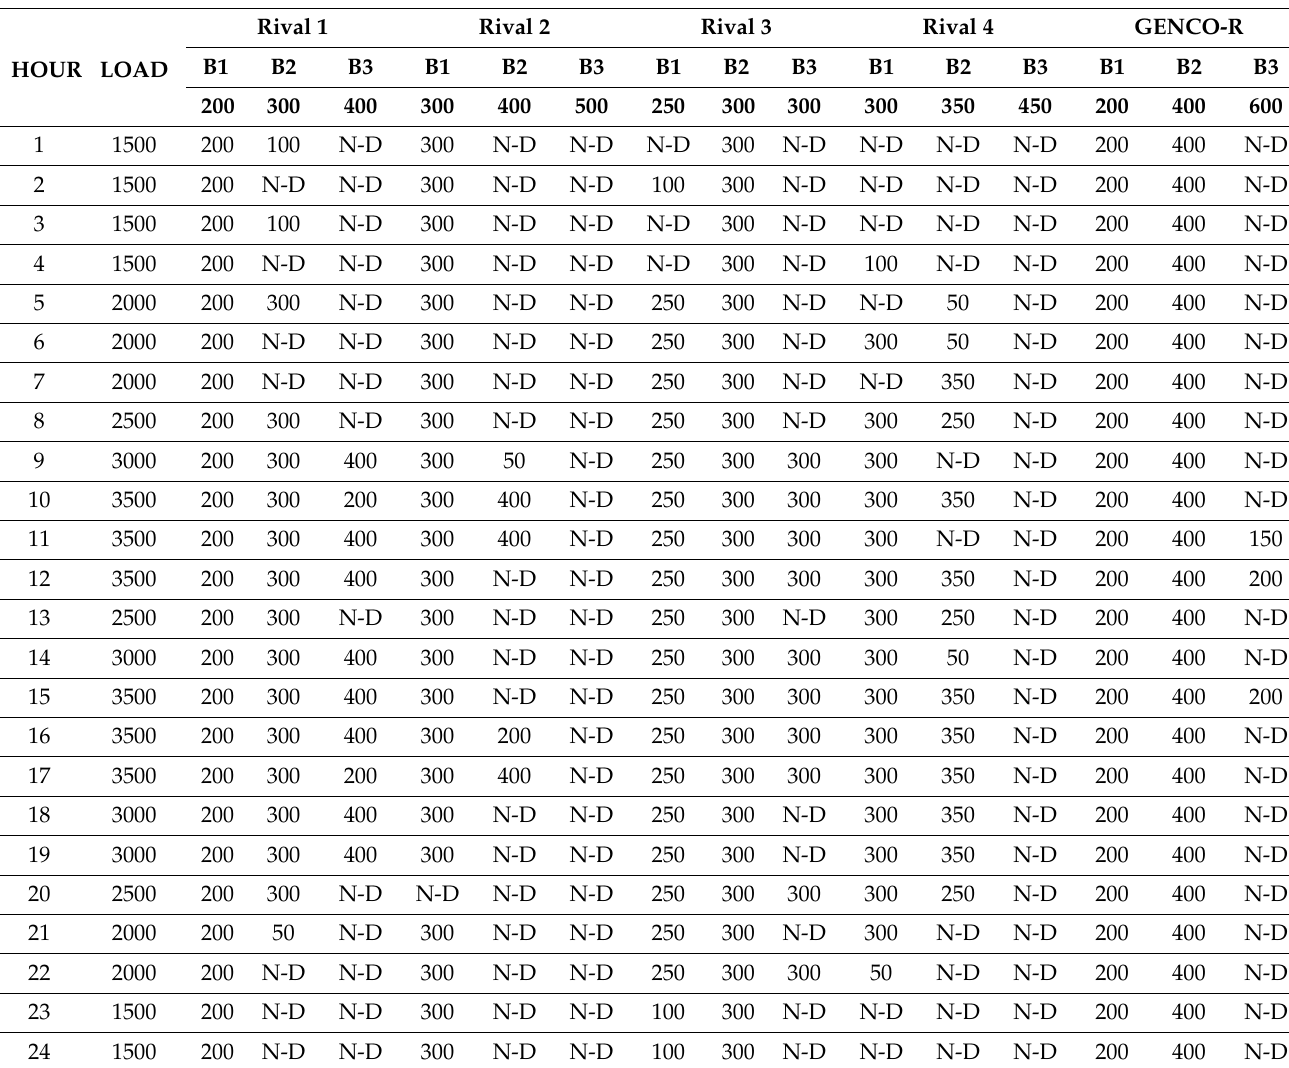
Table 10. Dispatch Obtained by Different Algorithms by using Lognormal PDF for